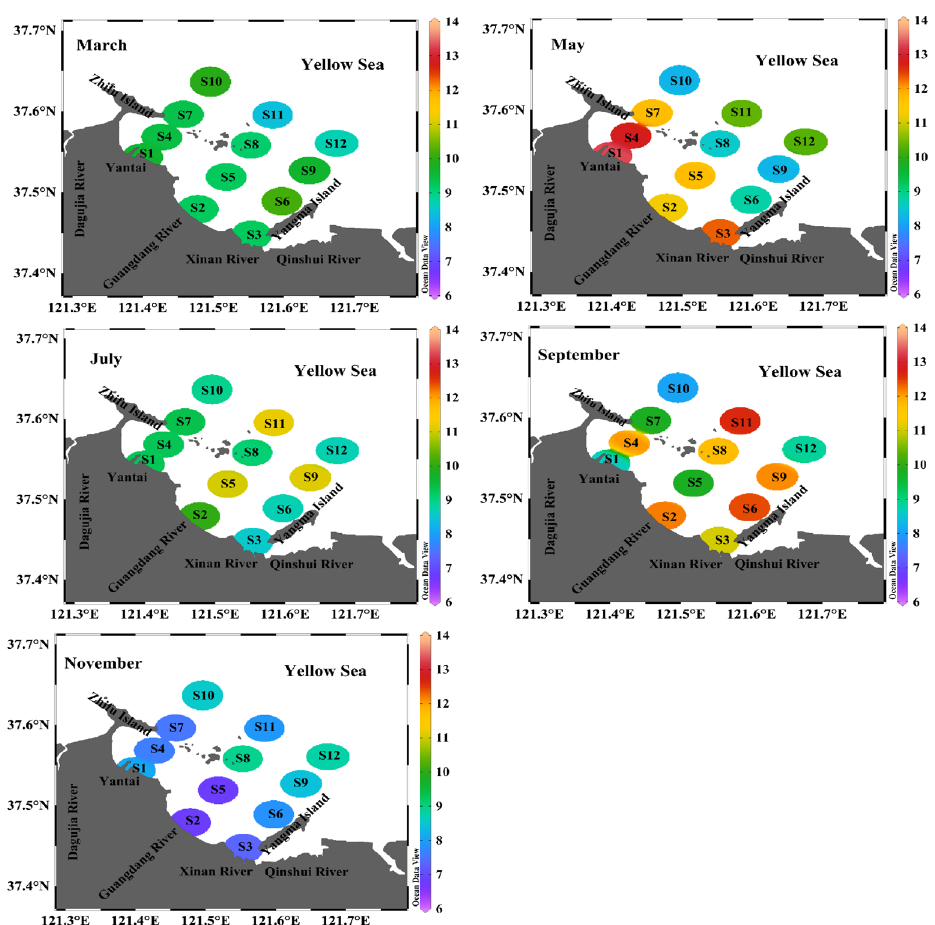
Figure 5. Spatial distribution of dissolved reactive iron (DrFe) (unit: nM) in Sishili Bay in different months of 2018.